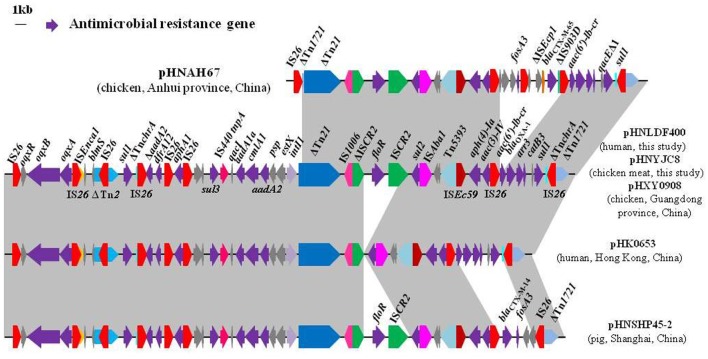
Comparison of the multidrug resistance regions of plasmids pHNLDF400 and pHNYJC8 with other similar IncHI2 plasmids. Arrows indicate the positions and directions of gene transcription. Regions with >99% homology are shaded in gray. ΔIndicates a truncated gene. The 1-kb distance scale is displayed in the upper left corner. Sequences were obtained from GenBank accession numbers pHNAH67, KX246266; pHXY0908, KM877269; pHK0653, KT335433; and pHNSHP45-2, KU341381.